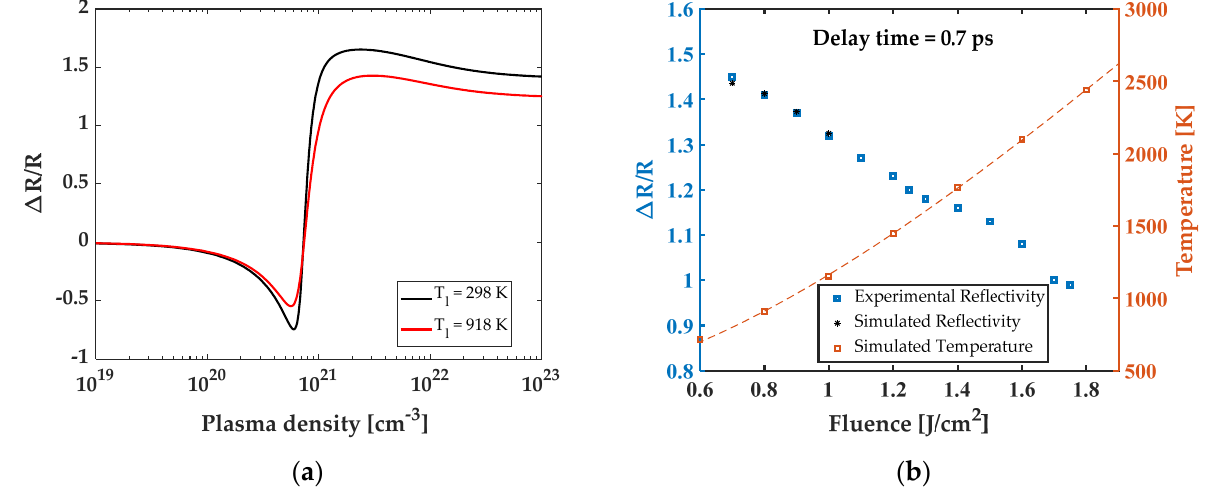
Figure 8. ( a ) Comparison using the refractive index at room temperature and at the predicted tem- perature when the laser fluence is 0.8 J/cm 2 . ( b ) Theoretical reflectivity characteristic and maximum lattice temperature as a function of fluences when taking temperature-dependent refractive index.